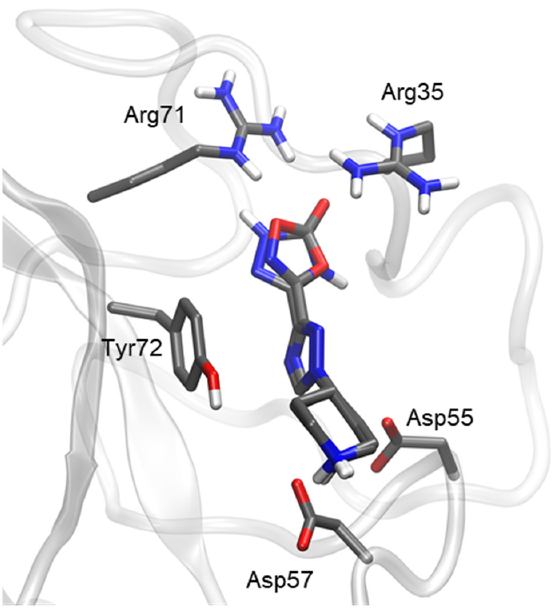
Figure 7. Docking of most representative poses for 1,2,4-triazole derivatives (compounds 9 and 10 ). Docking studies were performed with Kringle 1 lysine binding site (pdb code 1cea) using AutoDock